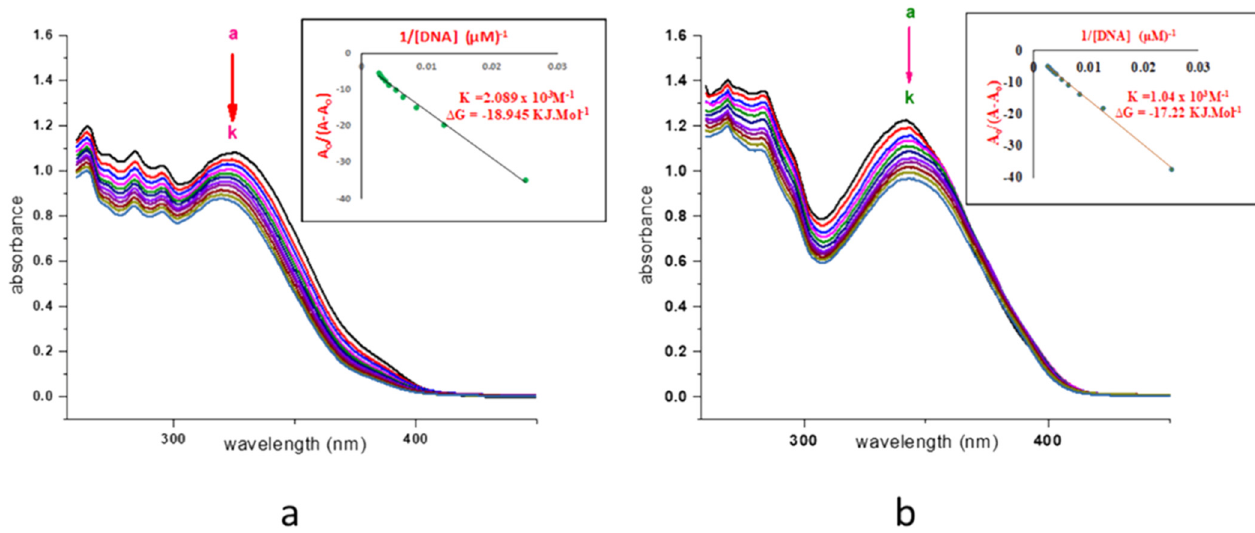
Figure 7. DNA Binding study of ligand and its Zn(II) complex. Figure 7. ( a ) DNA Binding study of ligand ( b ) DNA Binding study of Zn(II) complex. (a–k, represent addition of DNA from 0.1 mL to 1.1